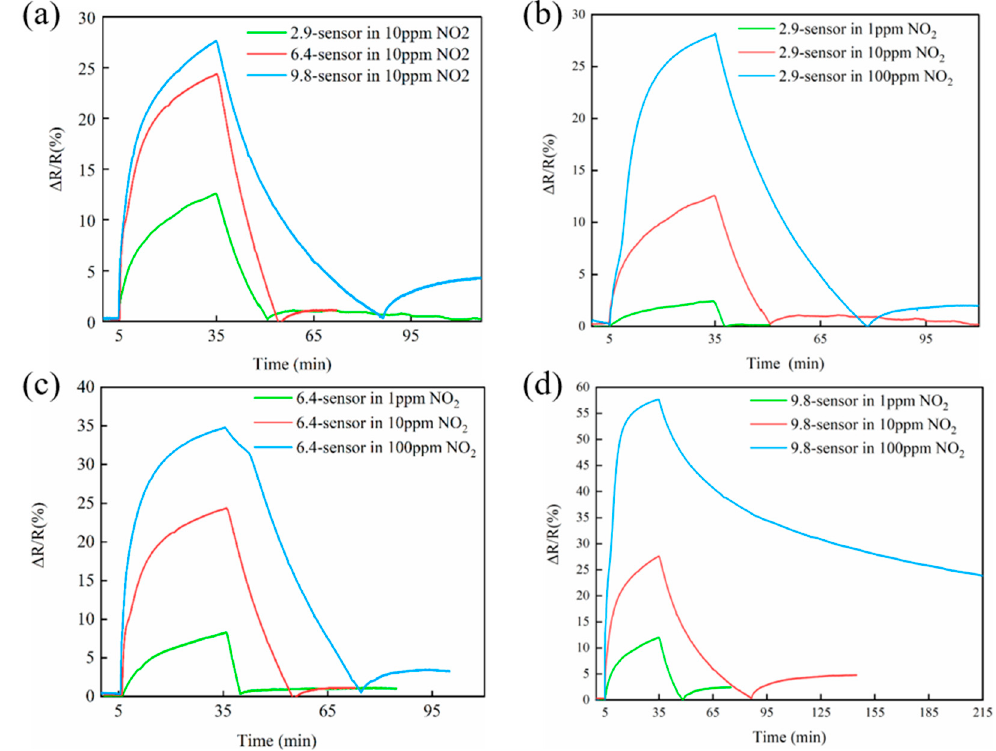
Figure 4. ( a ) Responsivity of the sensors exposed to 10 ppm NO 2 . ( b – d ) Sensing performance of the sensors exposed to different concentrations of NO 2 .